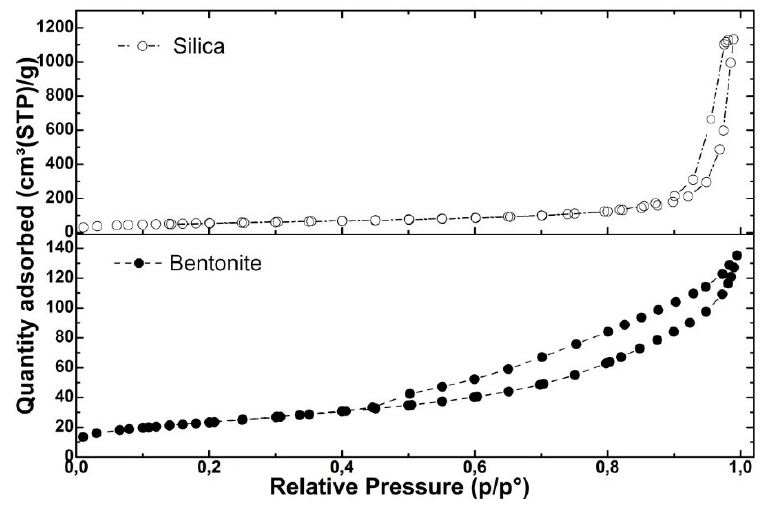
Figure 1. Nitrogen adsorption/desorption isotherms obtained with bentonite and silica at 77